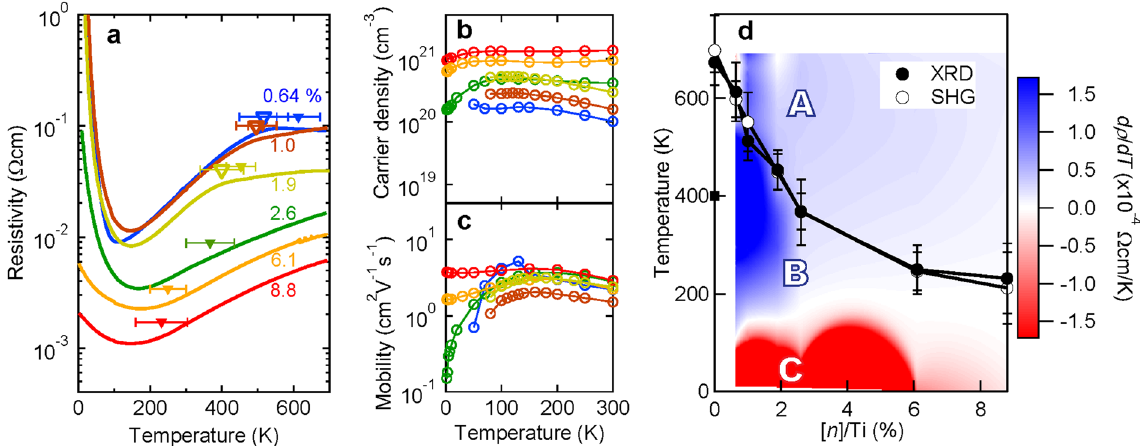
Figure 3. Transport properties of La-doped BaTiO 3 films. Temperature dependence of ( a ) resistivity, ( b ) carrier density, and ( c ) mobility for La-BTO films from [ n ]/Ti = 0.64% to 8.8%. Closed triangles in ( a ) denote the transition temperature from the non-polar phase to the polar phase determined by XRD and open triangles denote the kink temperature where the slope of resistivity as a function of T changes. ( d ) Phase diagram of the films. Non-polar to polar transition temperatures determined by XRD shown as closed circles and by SHG shown as open circles are plotted with the counter plot of differentiation of ρ ( Τ ), d ρ / d Τ . A phase: paraelectric metal, B phase: polar metal, and C phase: polar insulator are